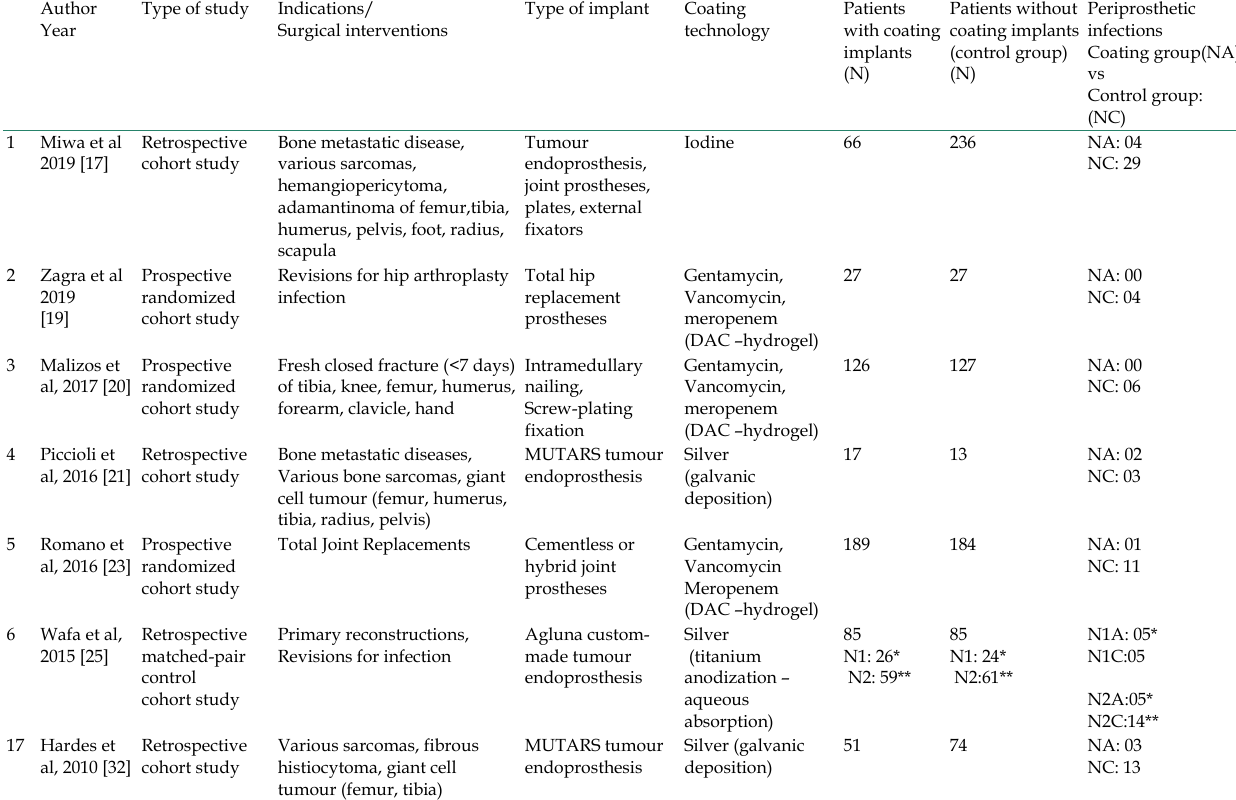
Table 1. Clinical data of antimicrobial coated internal, external fixation implements and endoprostheses.